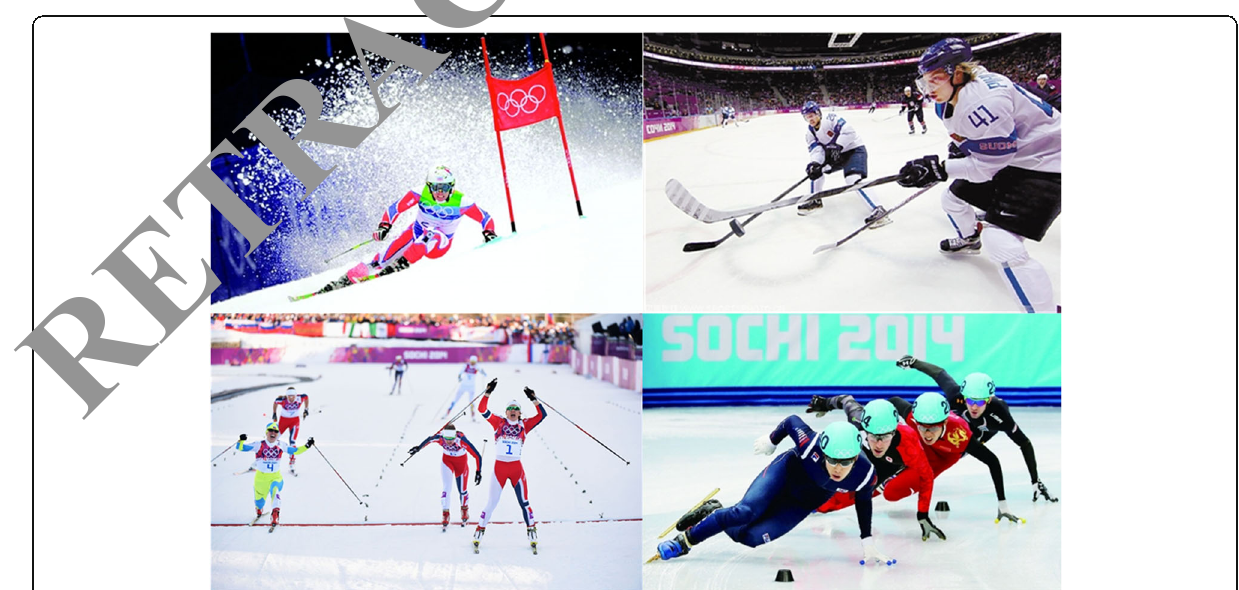
Fig. 1 The importance of environmental sustainability to the Winter